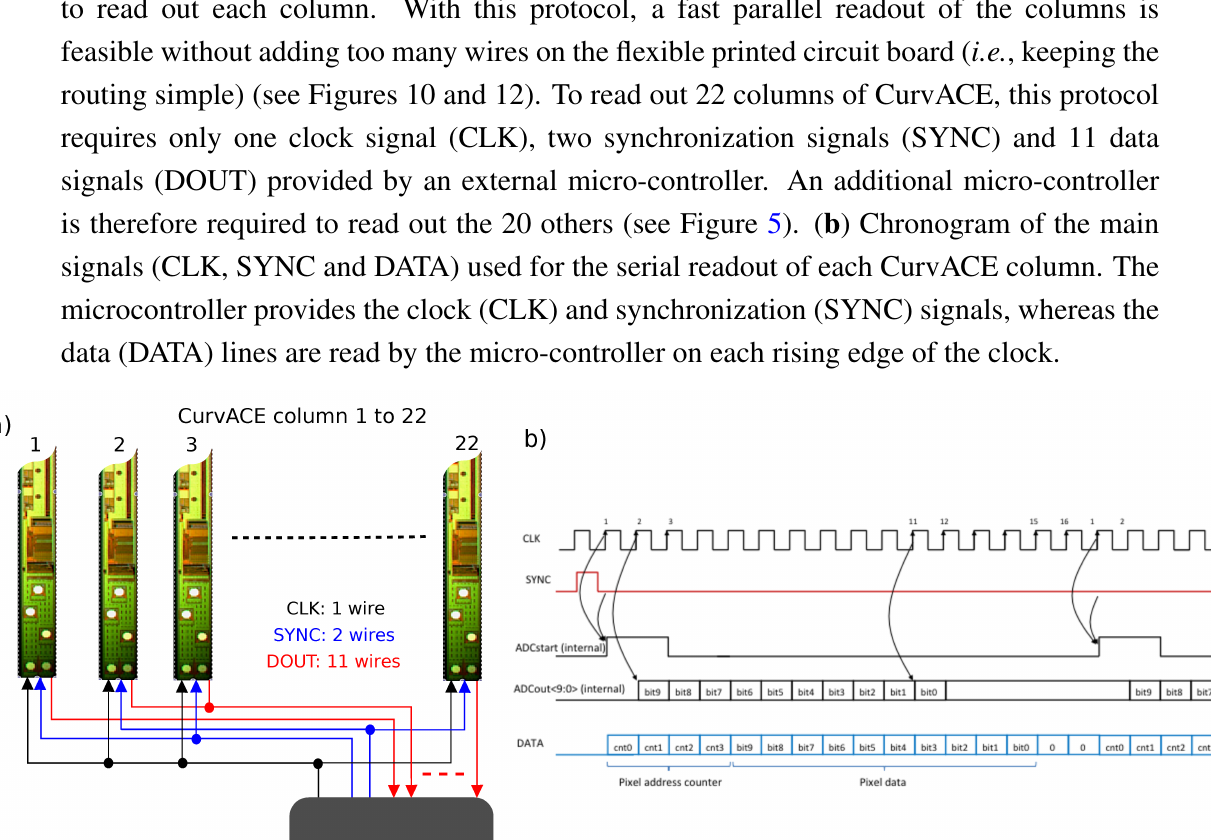
Figure 4. ( a ) Functional scheme of the direct connection protocol (DCP) specially designed to read out each